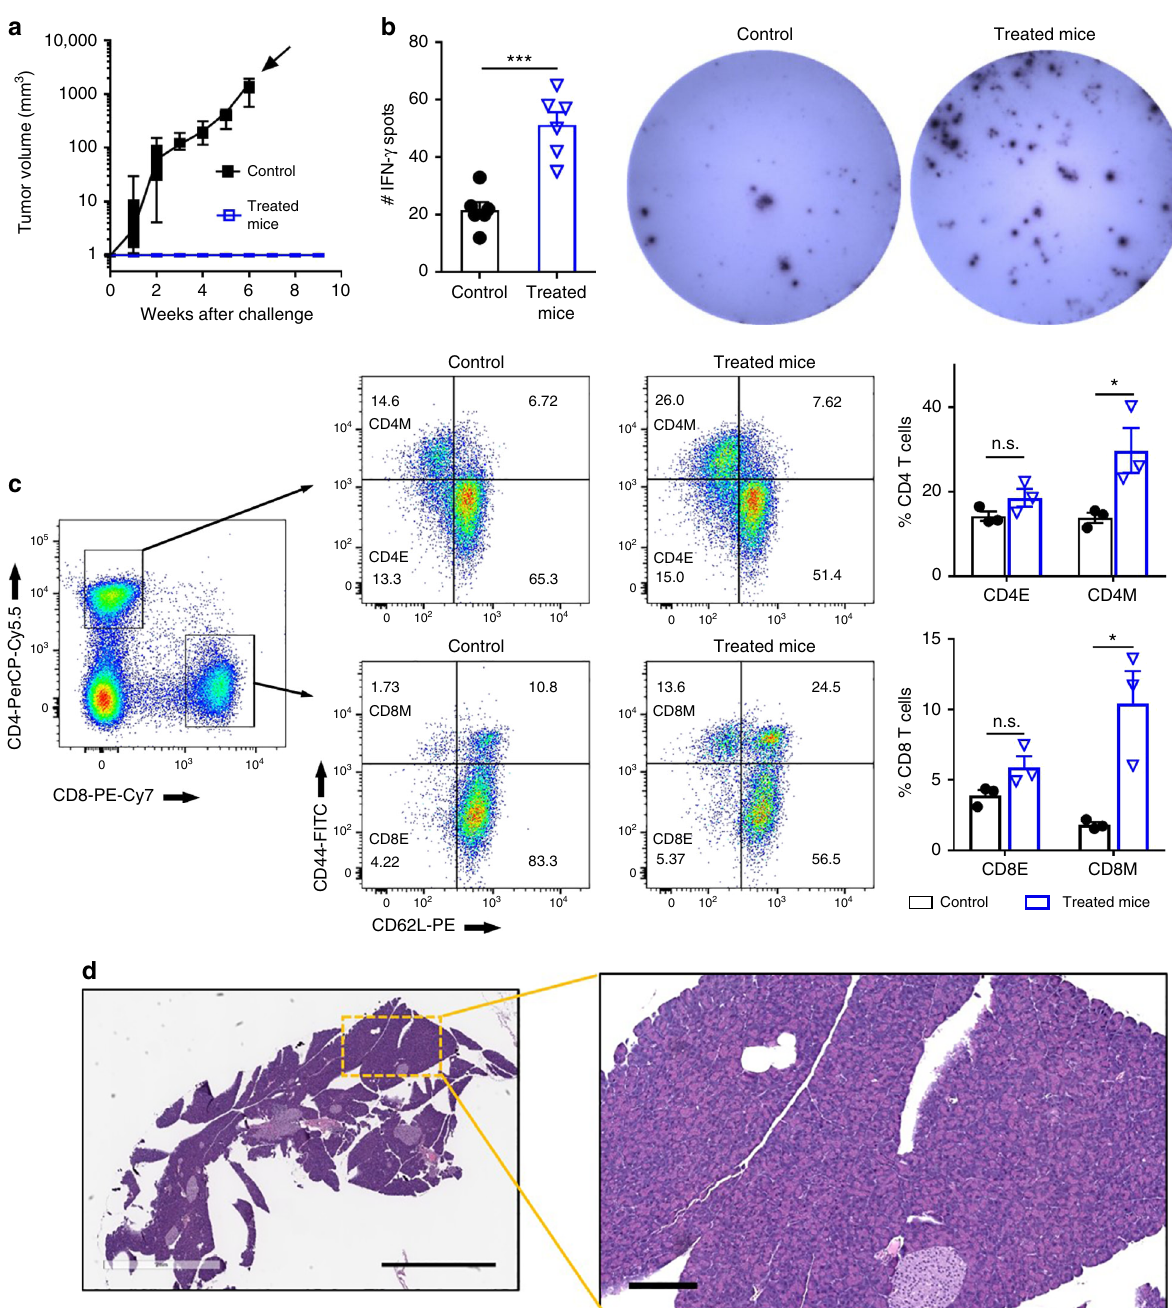
Fig. 4 IRE + anti-PD1 generated long-term immune responses. a Growth curve of rechallenging tumors in the long-term surviving mice treated with IRE + anti-PD1 (blue square, n = 10). Age-matched healthy mice that went through sham surgery at the same time of the treated mice were used as controls (black solid square, n = 9). Time point of euthanasia is indicated by a solid arrow. Data presented as interquartile range (IQR) with a median center line and min to max error bars. There was no growth of rechallenging tumor in the long-term surviving mice. Their volume was assigned to be 1 mm 3 in order to be visible on the semi-logarithmic scale. b , c Analyses of splenocytes isolated from re-challenged mice (blue triangle) at 9 weeks after inoculation of secondary tumor. Age-matched healthy mice (black solid circle) that went through sham surgery at the same time of the treated mice were used as controls. b Quanti fi cation of IFN- γ spots and representative images from the ELISPOT assay. Murine bone marrow-derived DCs were pulsed with KRAS* cell lysate, then co-incubated with splenocytes to induce secretion of IFN- γ . Spleens from 3 mice per group were analyzed with a technical duplicate for each spleen ( n = 6). c Representative fl ow cytometry plots and quanti fi cation of effector cells (CD44 − CD62L − ) and memory cells (CD44 + CD62L − ) among CD4 + and CD8 + T cells isolated from splenocytes. Three spleens were analyzed for each group ( n = 3). Data are presented as mean ± SEM in panels ( b ) and ( c ). * p < 0.05, *** p < 0.001. CD4M, CD4 memory cells (CD4 + CD44 + CD62L − ); CD4E, CD4 effector cells (CD4 + CD44 − CD62L − ); CD8M, determined by two-sided Student ’ s t- test. d Representative hematoxylin – eosin staining of tumor-free pancreas in KRAS*-bearing mice that were treated with IRE + anti-PD1, and had survived more than 9 months after the initiation of treatments. Scale bar = 2 mm for the overview and 200 µ m for the inset. Source data are provided as a Source Data fi